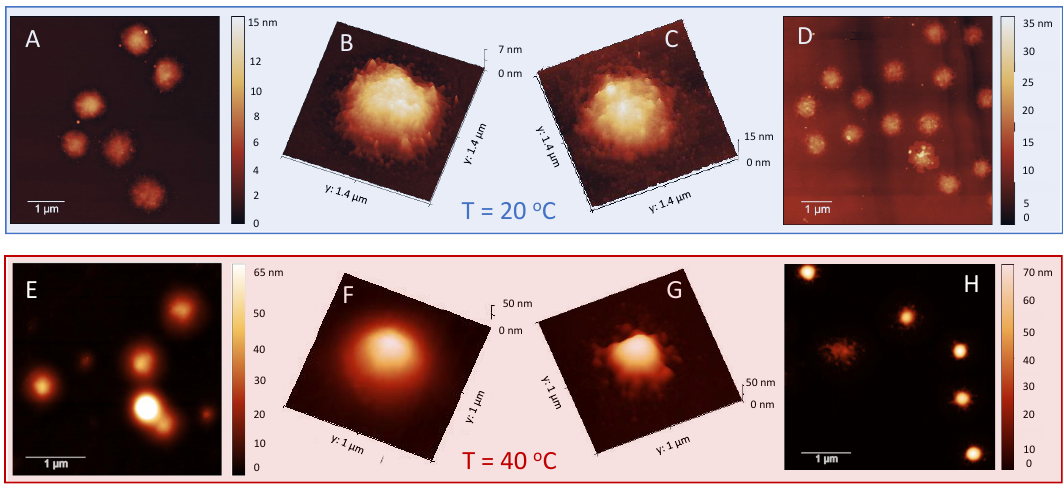
Figure 10. AFM images of P α 250/m1-KPS complexes formed at C = 0.0015 mg/mL (panels A , B and E , F ) and C = 0.01 mg/mL (panels C , D and G , H ), for T < T c (upper panel) and T > T c (lower panel). The presence of the PLL shell surrounding microgels is particularly evident above T c where a diffuse or globular-like corona is observed depending on PLL